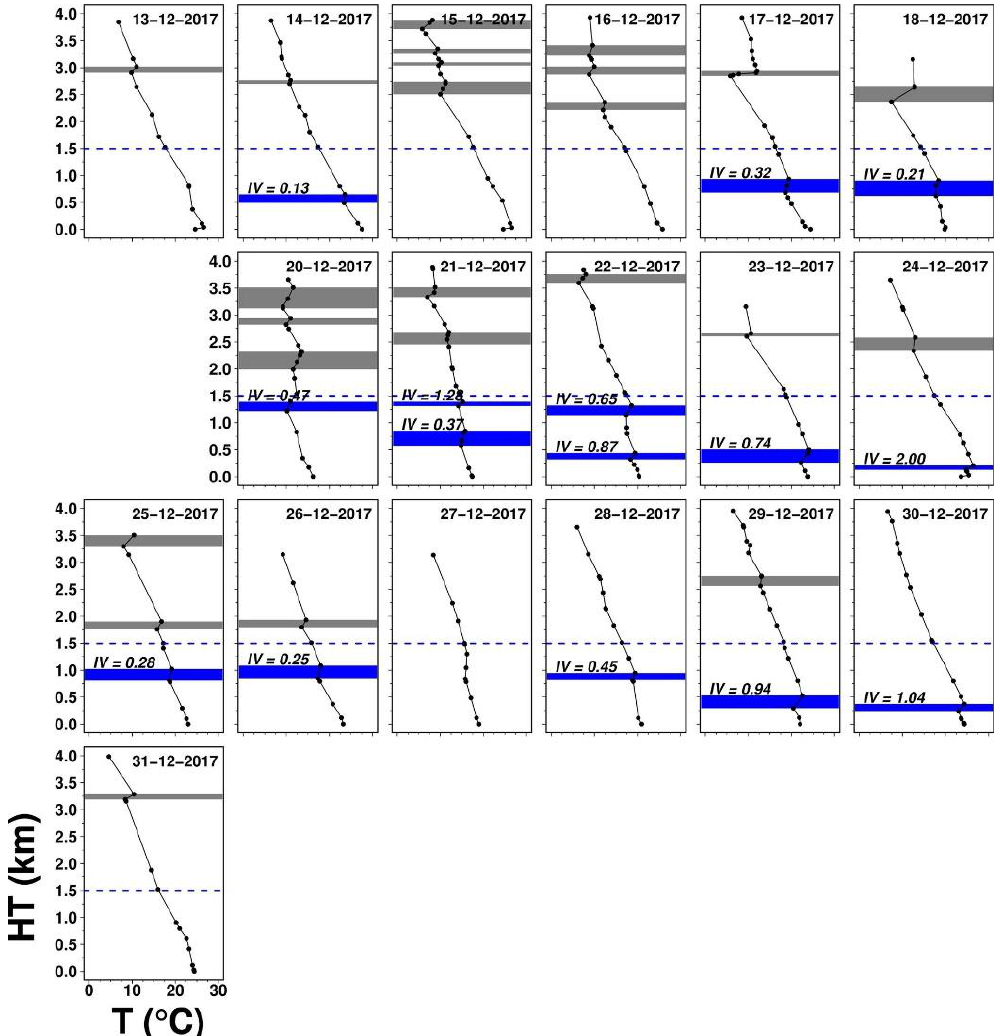
Figure 7. Same as Figure 4, but for haze episode EP2. IV represents the inversion intensity in ◦ C / 100 m .